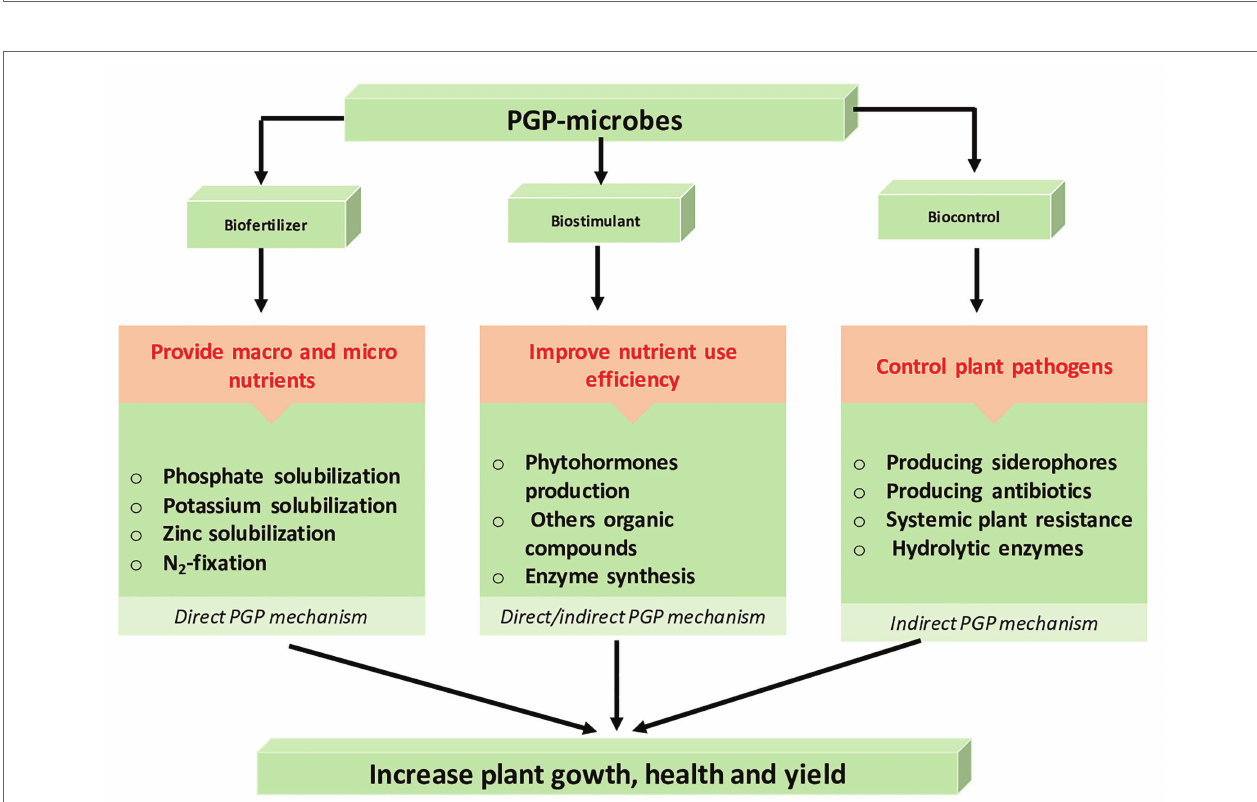
FIGURE 2 | Role and mechanisms of rhizospheric plant growth promoting